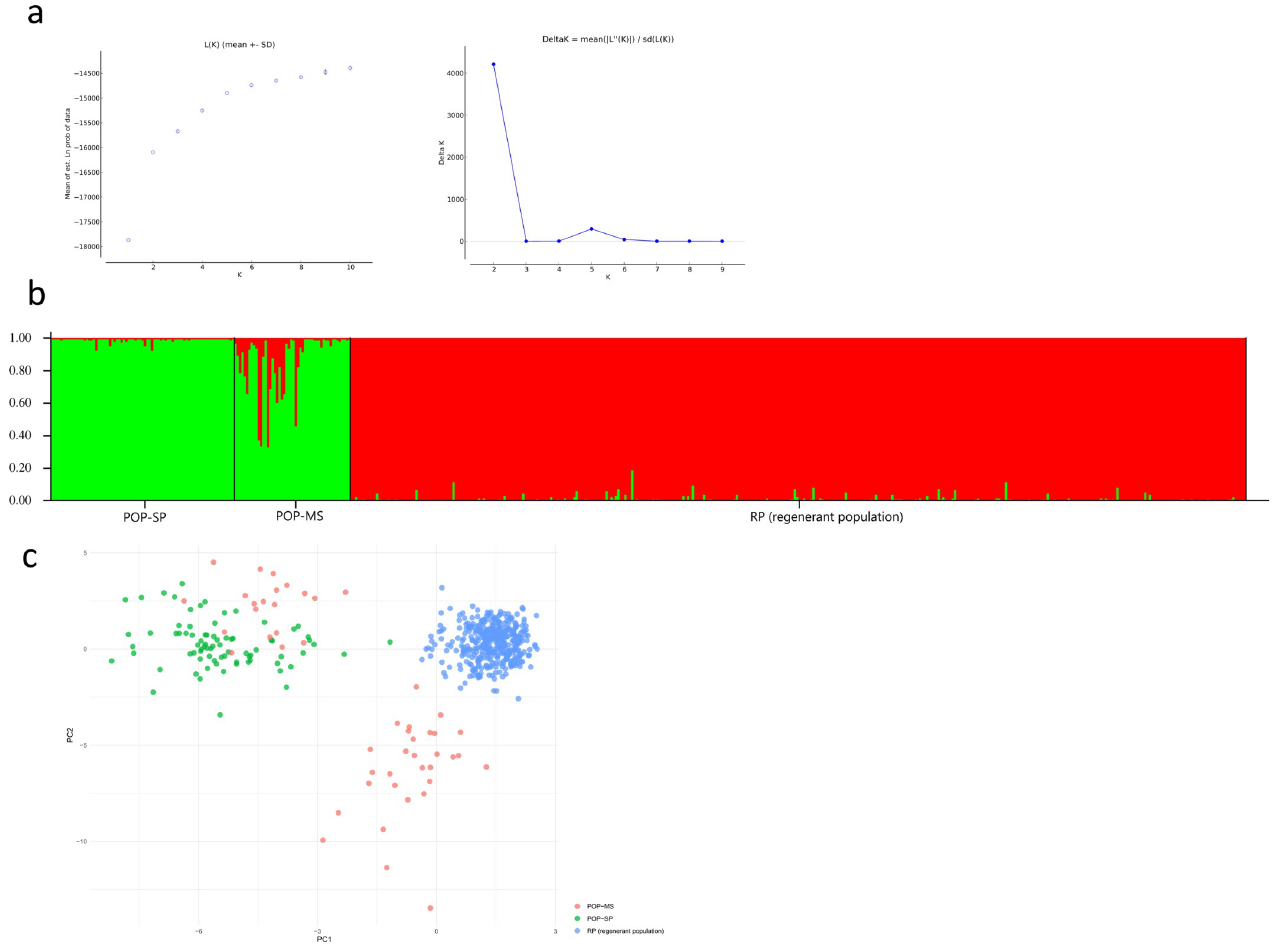
Fig 2. Population structure analysis of Astronium fraxinifolium . (a) Values of Ln P(k) and Delta (K) [48]. (b) STRUCTURE analysis showing two genetic clusters. (c) Principal component analysis.